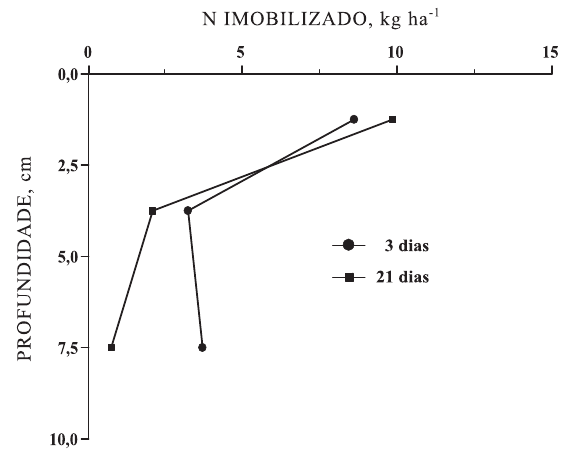
5%.Figura 2. Distribuição da quantidade de N imobilizado na camada de 0–10 cm, nas avaliações realizadas aos 3 e 21 dias após